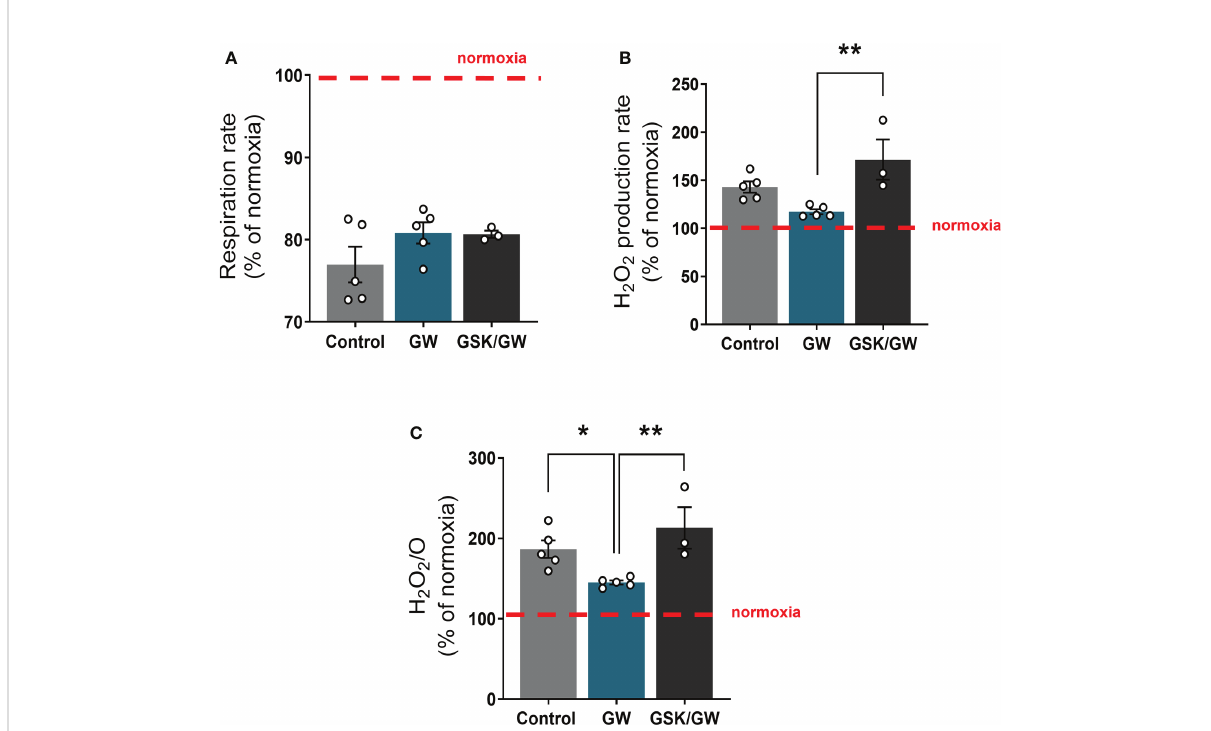
FIGURE 3 PPAR b / d activation ameliorates mitochondrial ROS production after in vitro anoxia/reoxygenation. (A) Respiration rate in cardiac homogenate (B) H 2 O 2 production rate corrected for the background slope determined in the absence of homogenate (C) H 2 O 2 % ratio between O 2 fl ow and H 2 O 2 production rate, all calculated as the ratio between the post-anoxia/reoxygenation values divided by the respective normoxic values. The fl uorescence signals were calibrated using H 2 O 2 titrations at the corresponding state. Results are presented as means ± SEM from 3-5 independent experiments. GW, pretreated with PPAR b / d agonist GW0742; GSK/GW, pretreated with PPAR b / d antagonist GSK0660 and then pretreated with PPAR b / d agonist GW0742. *p < 0.05, **p <